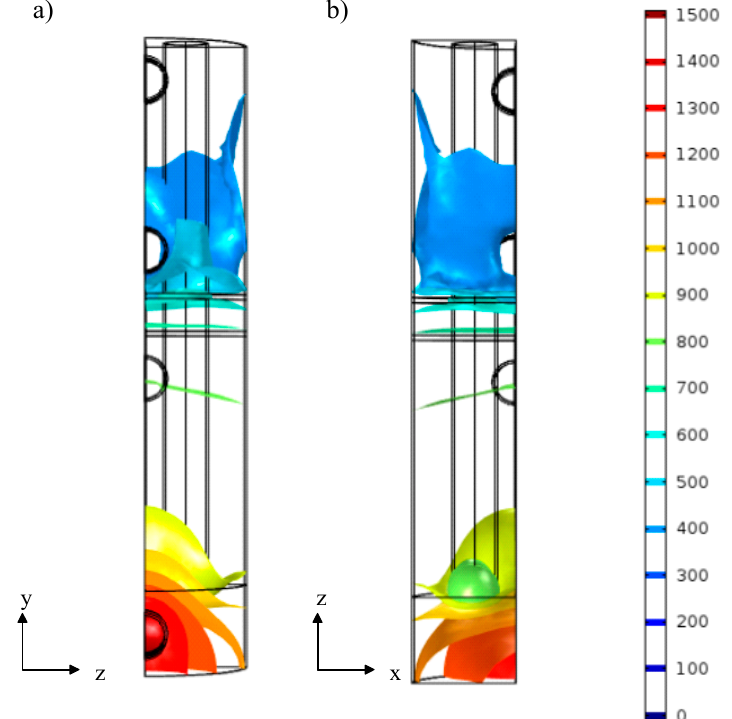
Figure 10. Temperature profile of CHIRS (II) in the ( a ) YZ plane and ( b ) XZ direction.